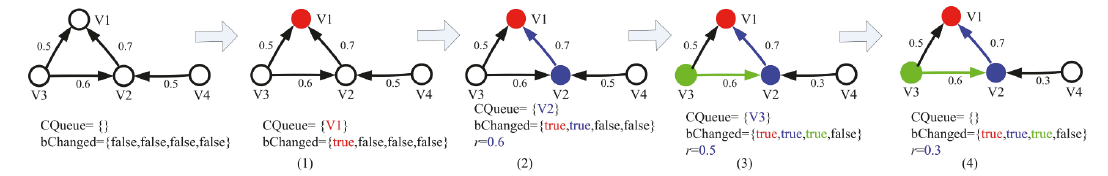
Figure 4: A simple example of change